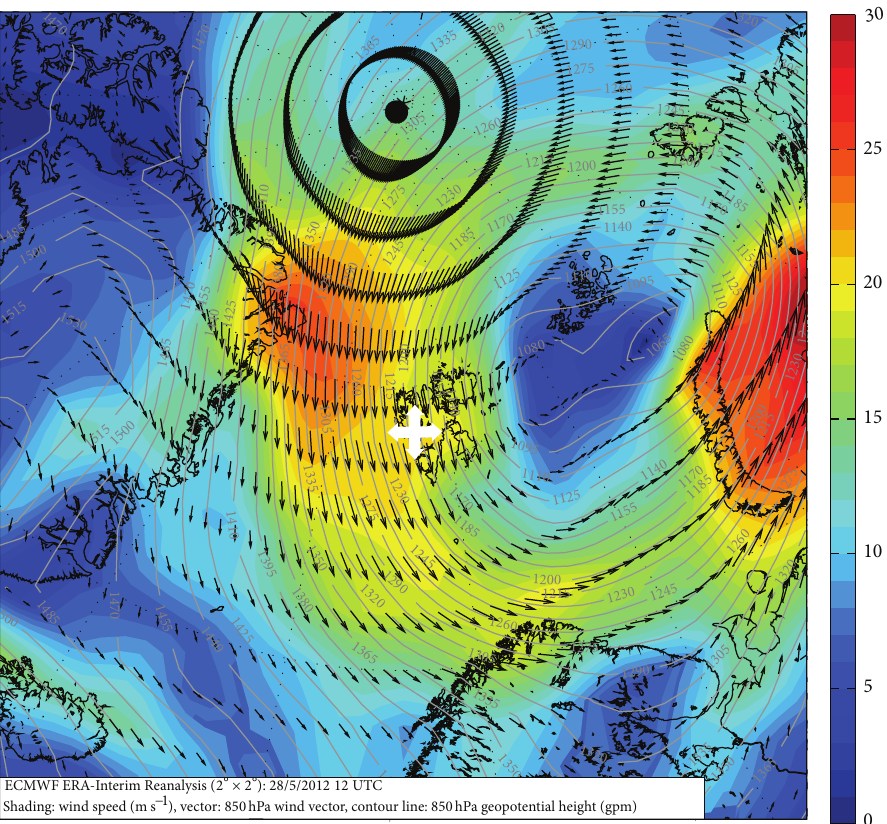
Figure 6: ERA-interim reanalysis data for 28.5.2012, 12 UTC. The wind velocity in 850 hPa is shown in different colours, the wind vector in 850 hPa with arrows, and the geopotential height in 850 hPa with lines. Additionally, Svalbard is marked with a white